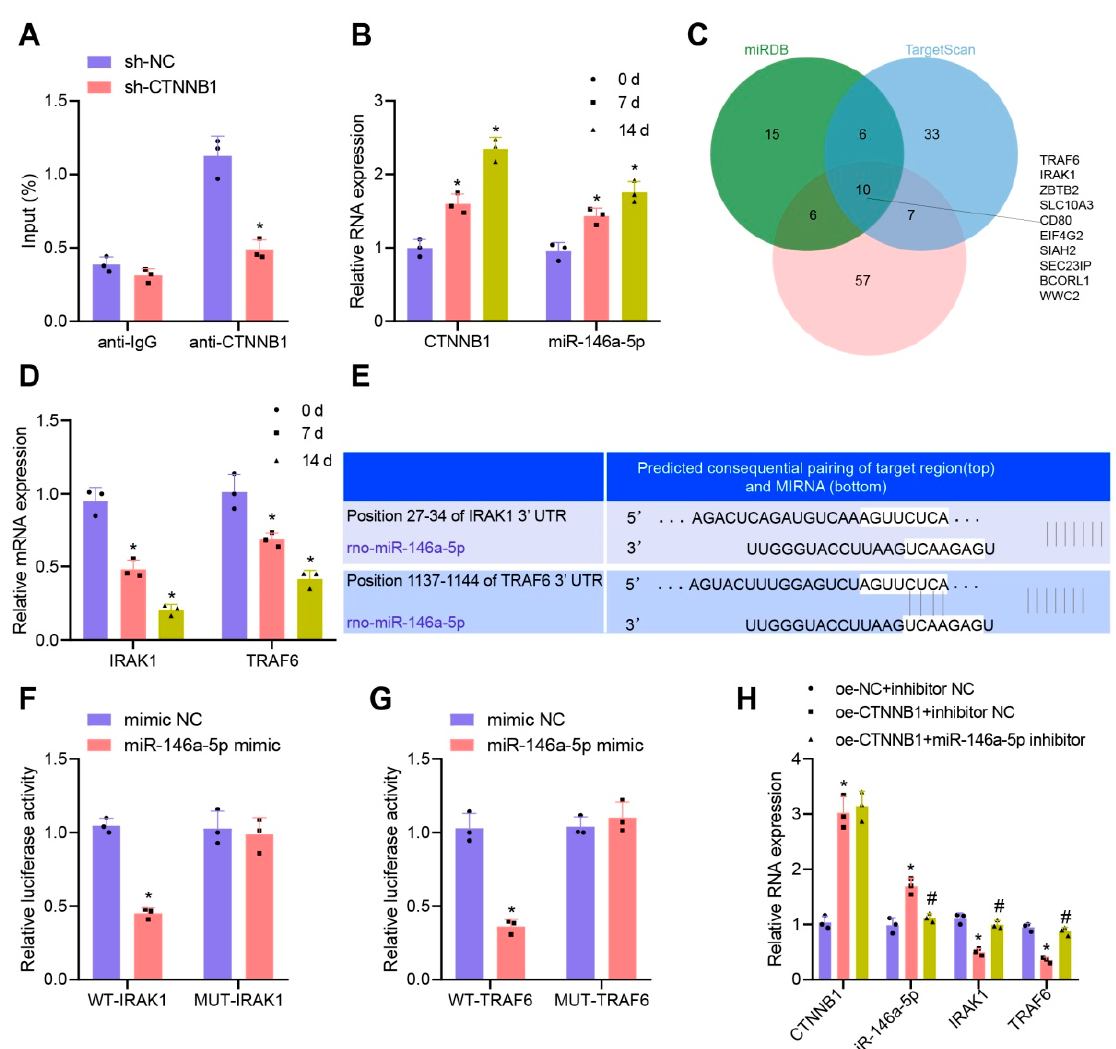
Figure 6. CTNNB1 activates the transcription of miR-146a-5p and further inhibits IRAK1 and TRAF6 during osteogenic differentiation of BMSCs. ( A ) ChIP for detection of the enrichment of CTNNB1 at the promoter region of the miR-146a-5p. ( B ) The CTNNB1 and miR-146a-5p expression after 0, 7, and 14 d of osteogenic differentiation of BMSCs determined by RT-qPCR. ( C ) Venn diagram for the intersection of miRDB, TargetScan, and DIANA TOOLS databases. ( D ) IRAK1 and TRAF6 expression after 0, 7 and 14 d determined by RT-qPCR. ( E ) The targeted binding sites between miR-146a-5p and IRAK1 and between miR-146a-5p and TRAF6 predicted through the TargetScan database. ( F ) Dual-luciferase reporter gene assay to verify the targeted binding relationship between miR-146a-5p and IRAK1. ( G ) Dual-luciferase reporter gene assay to verify the targeted binding relationship between miR-146a-5p and TRAF6. ( H ) Expression of CTNNB1, miR-146a-5p, IRAK1, and TRAF6 in BMSCs upon CTNNB1 overexpression alone or combined with miR-146a-5p inhibition detected by RT-qPCR. * p < 0.05 vs. the sh-NC, 0 d, mimic NC, or oe-NC + inhibitor NC group. # p < 0.05 vs. the oe-CTNNB1 + inhibitor NC group. Cell experiments were independently repeated three